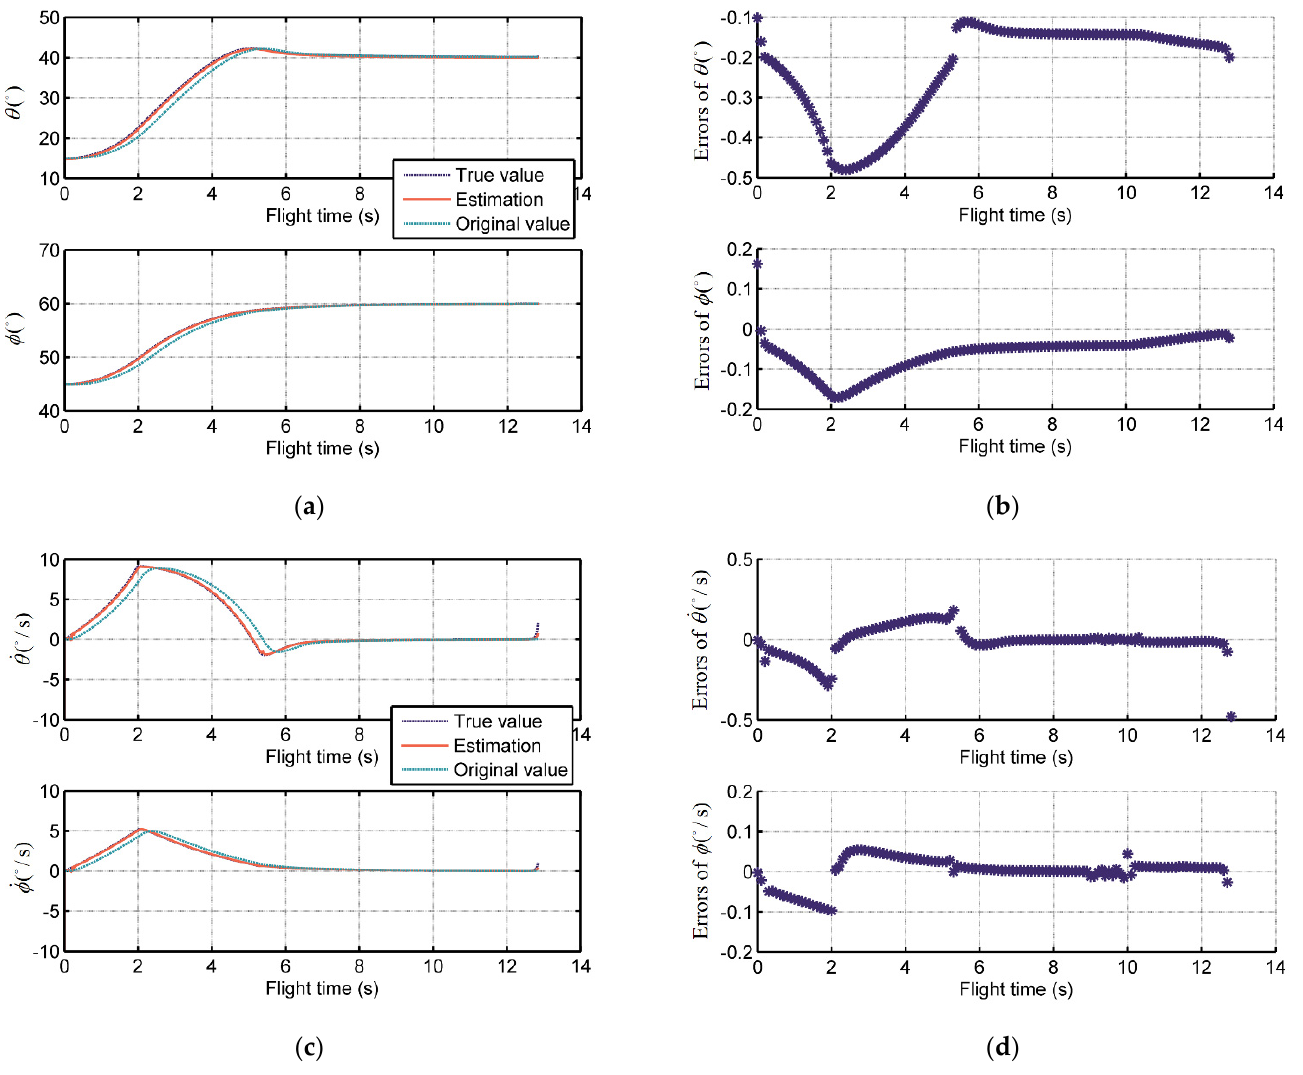
Figure 4. The performance of the proposed predictive ADRC compensation system for seeker lag and time delay: ( a ) True value, estimation, and original value of LOS angle; ( b ) Errors between true value and estimation of LOS angle; ( c ) True value, estimation, and original value of LOS angular rate; ( d ) Errors between true value and estimation of LOS angular rate.